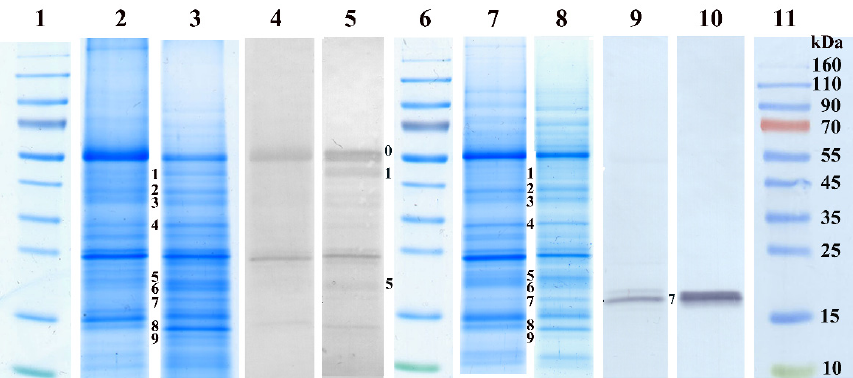
Figure 3. Changes in the leaf polypeptide patterns and in the density of dehydrin bands of H. rhodopensis shade (lanes 2–5) and sun plants (lanes 7–10) under drought stress. Polypeptide patterns of control (lanes 2, 4, 7, and 9, RWC 80–90%) and dried leaves (lanes 3, 5, 8, and 10, RWC 8%) either stained (lanes 2, 3, 7, and 8) or blotted against dehydrin (lanes 4 and 5) and sHSPs (lanes 9 and 10). Bands of increased intensity under the stress are numbered next to the Western blots. Lanes 1, 6, and 11: Fermentas Page Ruler Prestained Protein SM0671 (Thermo Fisher Scientific, Waltham, MA, USA) standards.